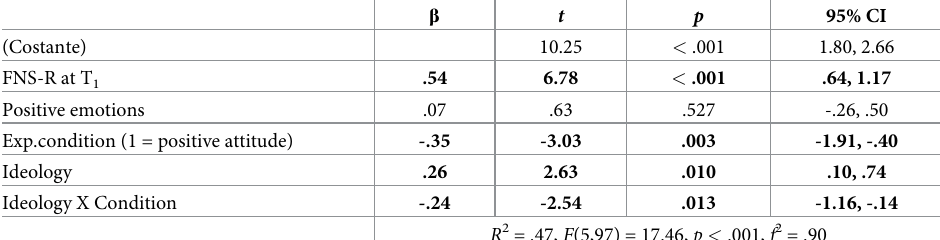
Table 8. Results of linear regression on participants’ neophobic choice (Study 4).